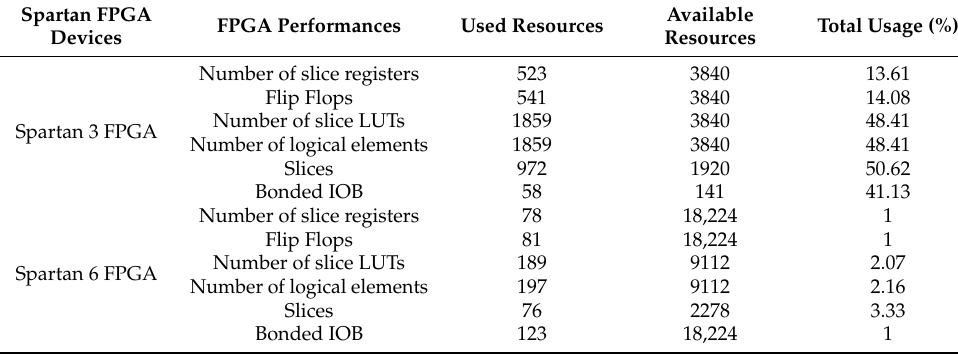
Table 4. Analysis of used resources for AES-FJMKE designed in Spartan devices.